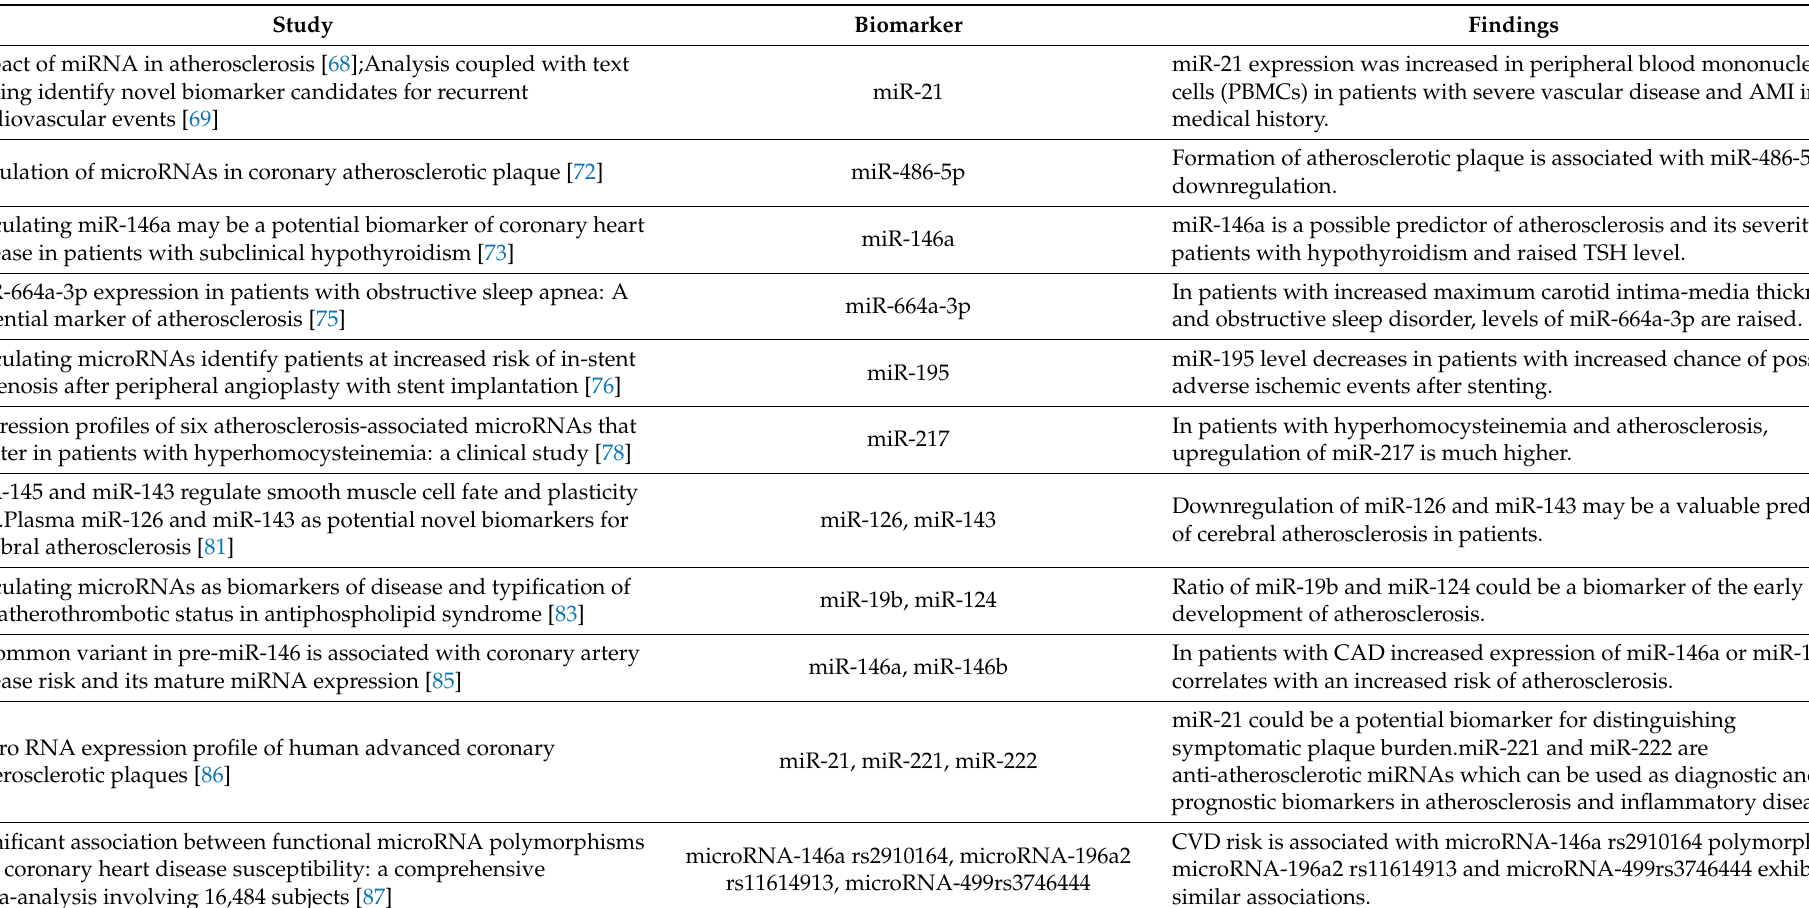
Table 2. Summary of findings about diagnosis and prognosis from studies concerning potentially new CVD